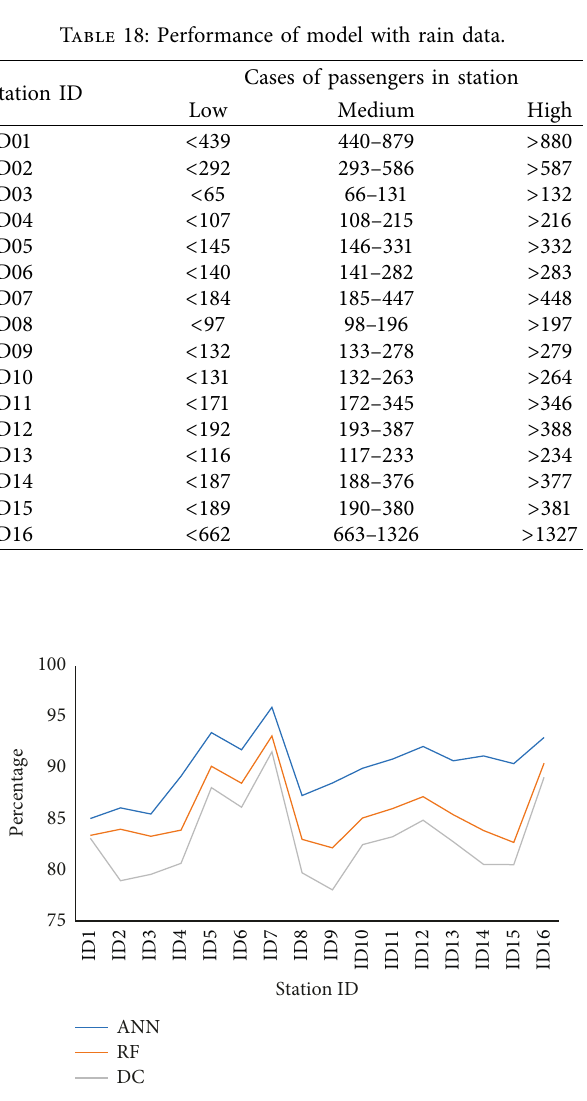
Figure 7: Accuracy of model for each